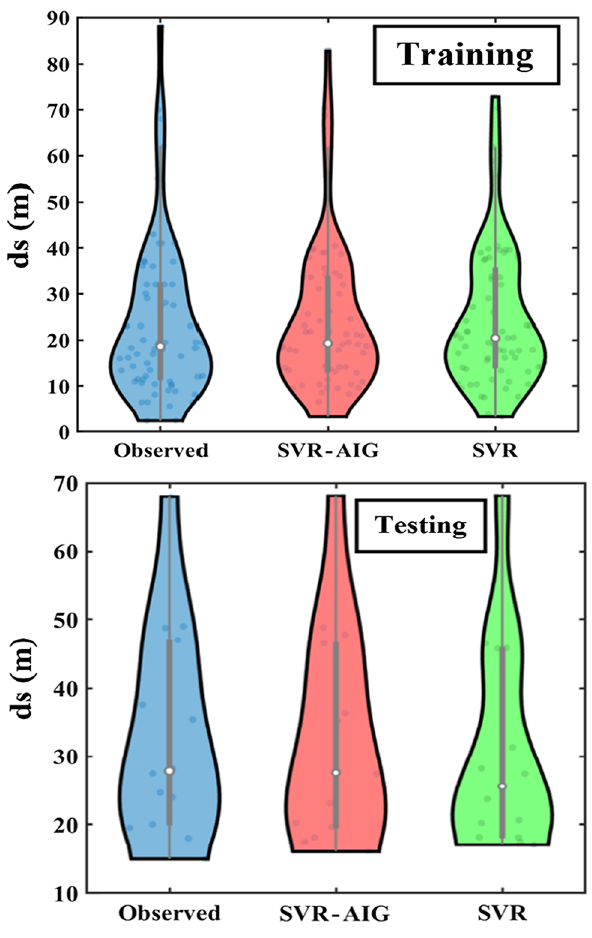
Fig. 7 Violin plots of the models at the training and testing